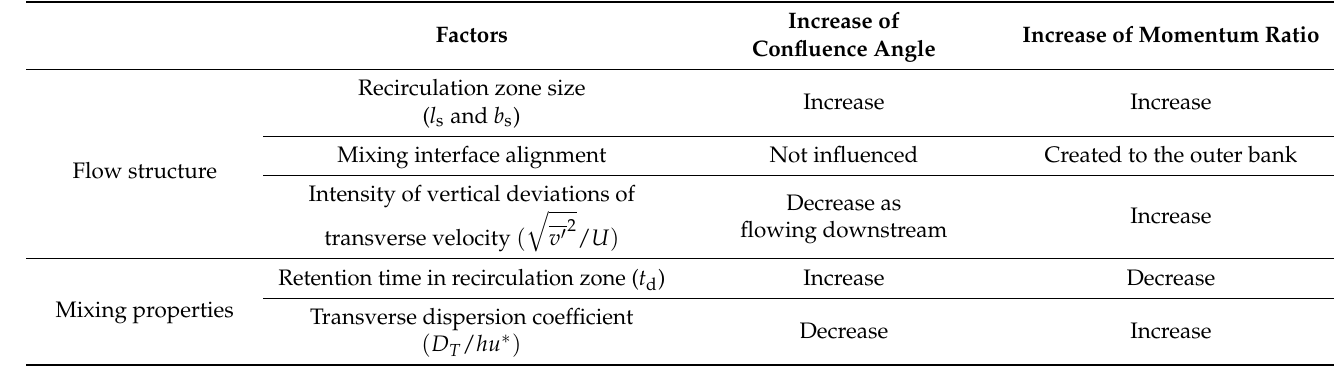
Table 4. Effects of the confluence angle and momentum ratio to flow and mixing properties in